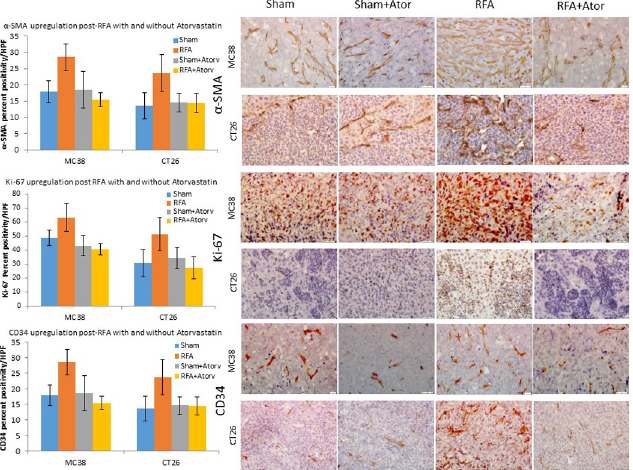
there was no difference in the assayed markers when comparing sham, sham plus atorvastatin and RFA plus atorvastatin indicating successful reduction of cellular markers to baseline levels with atorvastatin treatment (p-value > 0.05 all comparisons). (Fig 5 and Table 3).